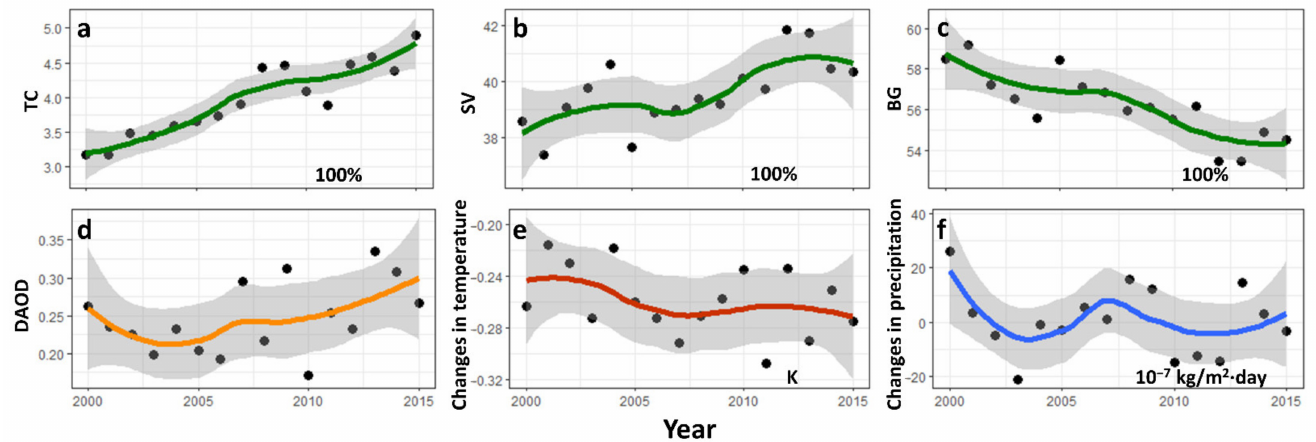
Figure 4. Temporal variance in vegetation, DAOD, temperature difference, and precipitation difference under the interplay of climate change and revegetation during 2000–2015 in northern China. ( a ) Tree canopy; ( b ) short vegetation; ( c ) bare ground; ( d ) change in spring-averaged DAOD; ( e ) temperature difference between scenarios B1 and B2: Dust-induced spring average temperature and scenario without dust influence; ( f ) precipitation difference between scenarios B1 and B2: Dust-induced spring average precipitation and scenario without dust influence. The trends of land cover, DAOD, temperature change, and precipitation change were respectively fitted with green, orange, red, and blue curves by the locally weighted regression (loess) method. The gray area represents the confidence interval of curve